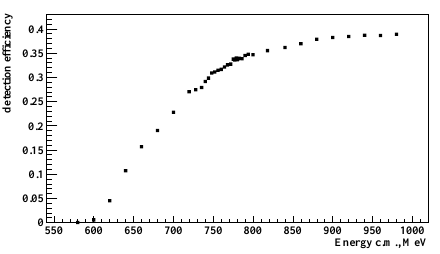
Figure 4. Comparison of our preliminary results on e + e − → π + π − π + π − cross section with the previous ex- periments:open circle - BaBar,triangle - CMD-2, full square- this work (1st scan), open square - this work (2nd scan), full circle - CMD-3 phi, open squares -